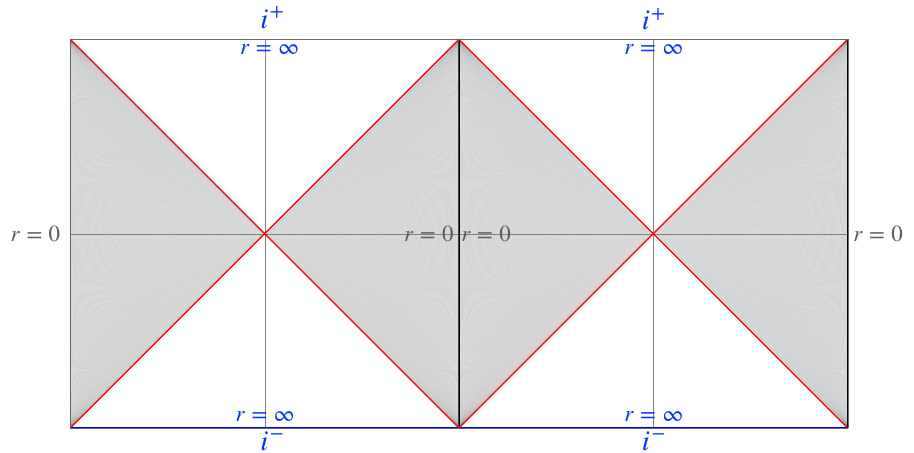
Figure 14 . Penrose diagram of dS 2 which contains two copies. In this diagram, we identify the two north poles located at r = 0 to glue the two copies